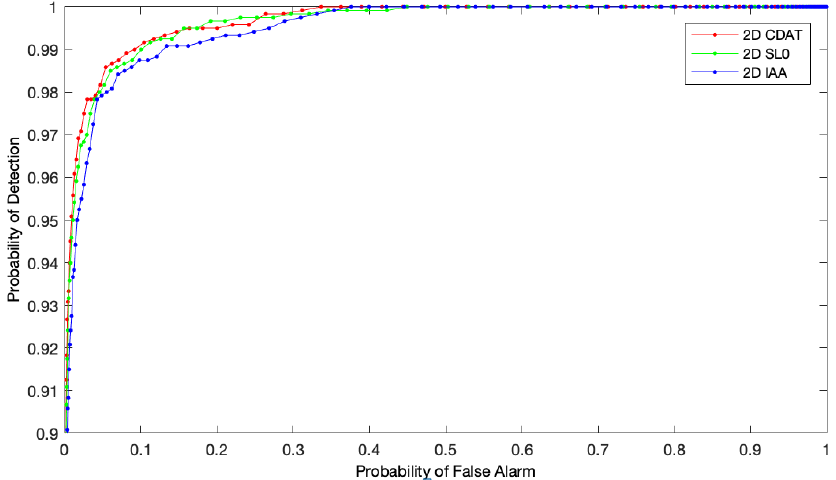
Figure 8. The average ROC curves of the compressive subtracted image recovered by different